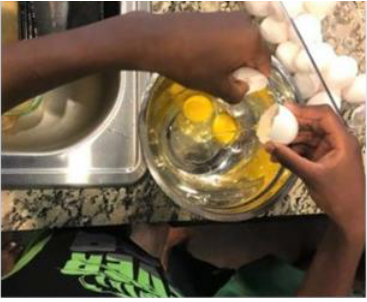
Figure 3. Child helping prepare breakfast (photograph submitted by